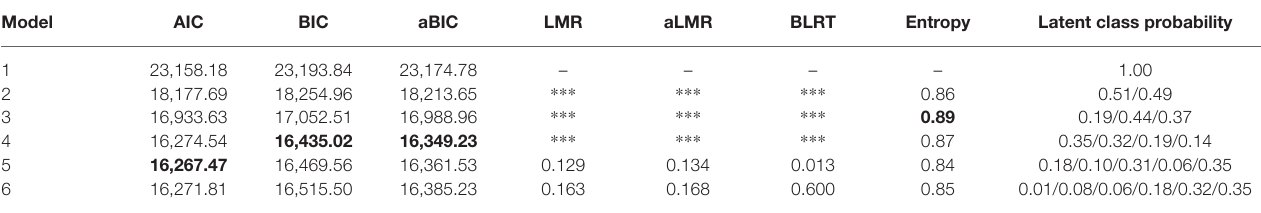
TABLE 3 | The goodness-of-fit indexes of exploratory LCA. Model